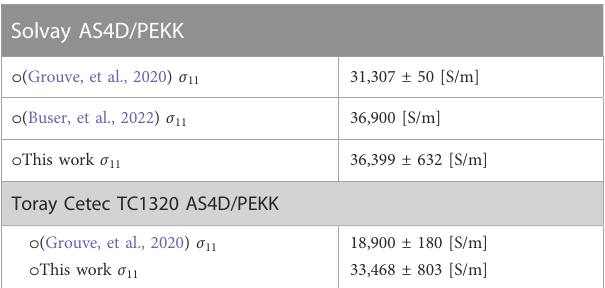
TABLE 2Electricalconductivity properties found inliterature andmeasured by NLR for AS4D/PEKK. Solvay AS4D/PEKK